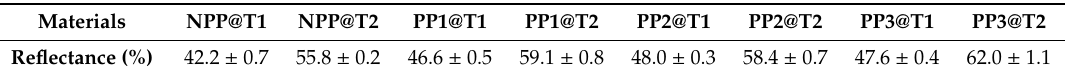
Table 3. Di ff use reflectance of the thin films with organic-inorganic hybrid particles at 600